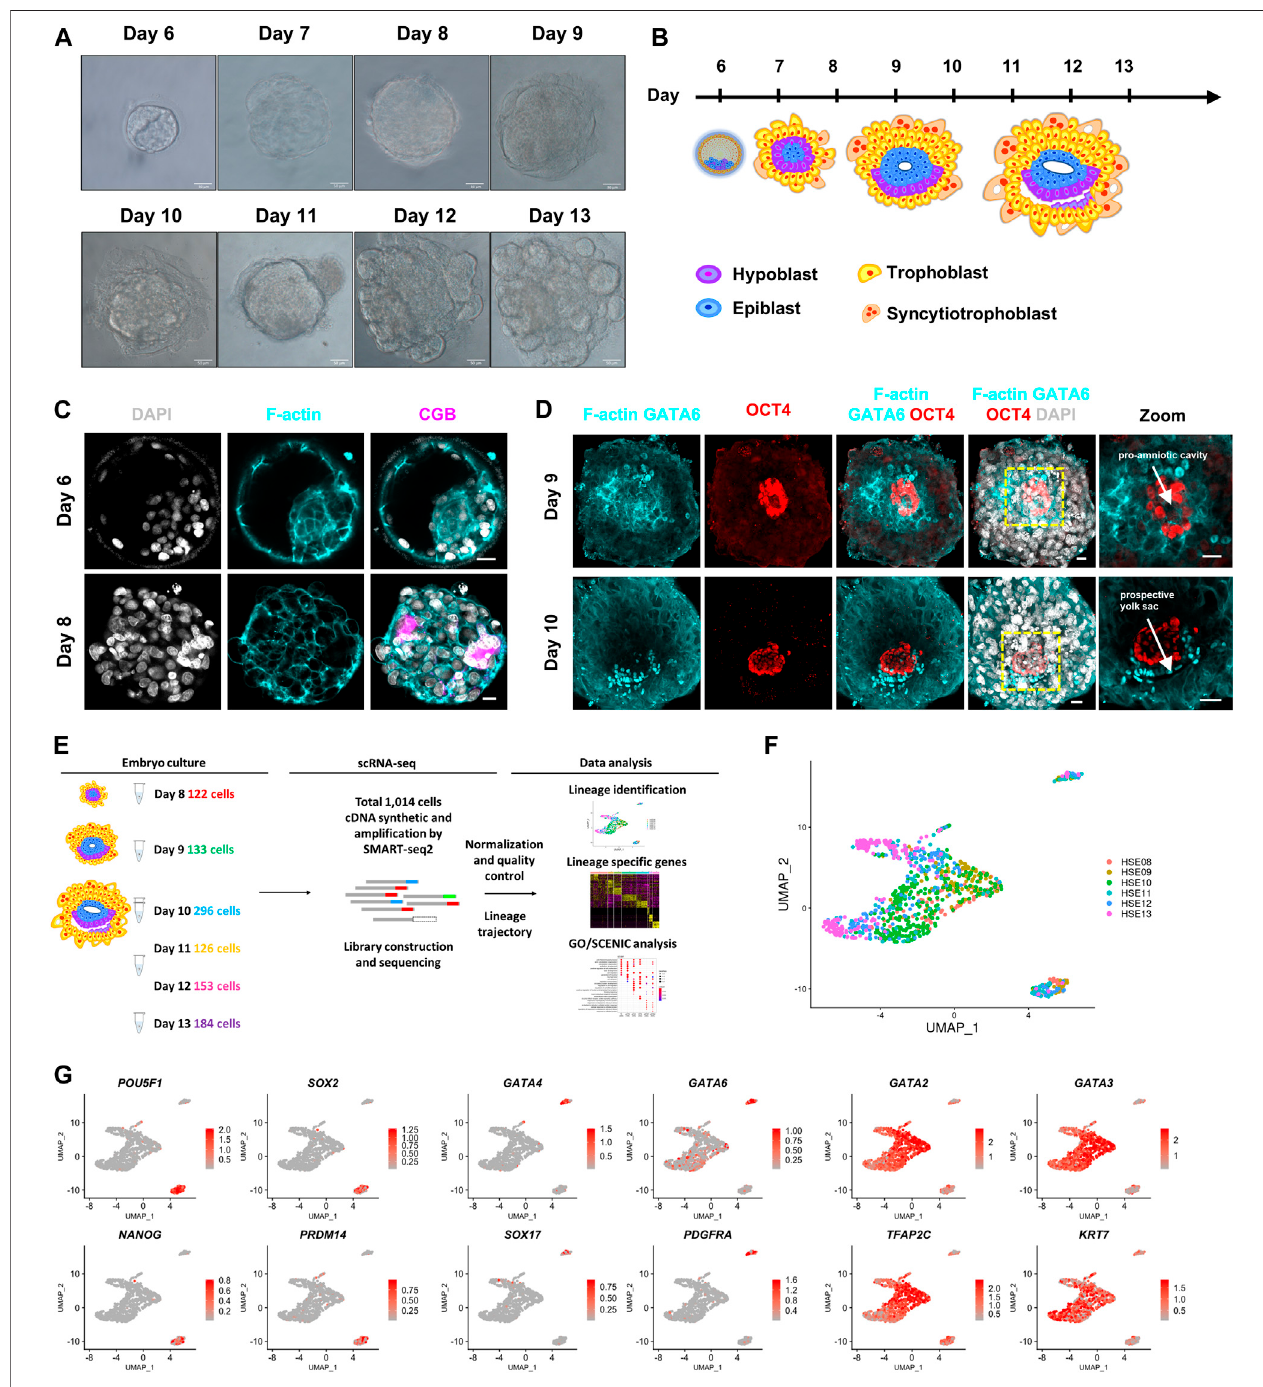
FIGURE 1 | Global expression pro fi ling of human embryo cells using single-cell RNA-seq and cell type identi fi cation. (A) Bright- fi eld images of in vitro cultured humanembryosfromday6today13.Scalebars,50 μ m. (B) CartoonsofhumanembryoimplantationmorphogenesisbasedonCarnegieseries. (C) Immunostainingof day 6 and day 8 human embryos ( n = 3 and n = 3) for F-actin and CGB. DAPI, grey, DNA. Scale bars, 20 μ m. (D) Immuno fl uorescence of day 9 and day 10 human embryos ( n = 3 and n = 1) for F-actin, GATA6, and OCT4. Images showing the pro-amniotic cavity and prospective yolk sac marked by white arrows. DAPI, grey, DNA. Scale bars, 20 μ m. (E) Work fl ow depicting the strategy of derivation of single cell from post-implantation human embryos. Number of cells every embryonic day (day 8-day 13) retained after quality fi ltering were shown. (F) UMAP plots showing single-cell transcriptomes of human embryos from day 8 – day 13. (G) UMAP plots showing the expression patterns of the lineage markers in human embryos. Color key from grey to red indicates relative expression levels from low to high, respectively.